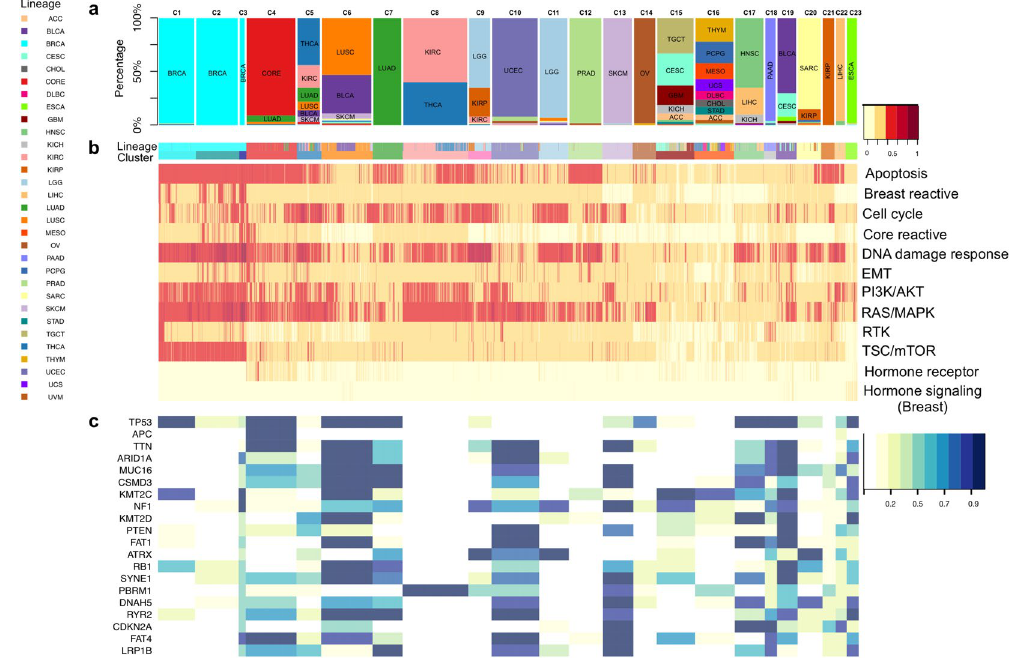
Figure 3. Network-based subtype stratification using PRECISE. ( a ) Proportions of tumor types represented in each cluster. ( b ) Heatmap depicting combined activated and suppressed PRECISE scores after unsupervised hierarchical clustering of the score matrix consisting of 6,844 patients across all cancer lineages and 12 proteomic signaling pathways. The scores are indicated on low-to-high scale (yellow-to-red). 23 clusters are defined. Annotation bars include tumor types. ( c ) Heatmap depicting enrichment probabilities (EP) of mutations for most frequently mutated 20 genes (across all clusters). The probabilities are indicated on low-to- high scale